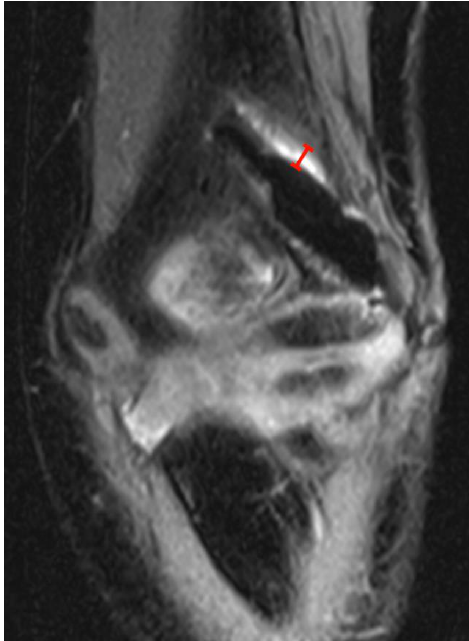
Figure 2. PD tse fs (proton density turbo spin echo fat-saturated) coronal image of the left elbow of a 7-year-old boy with a lateral humeral condyle fracture. The width of the hyperintense layer adjacent to the magnesium screw has been measured (red). Note the irregularity of the hypointense screw caused by gas locules along the screw.